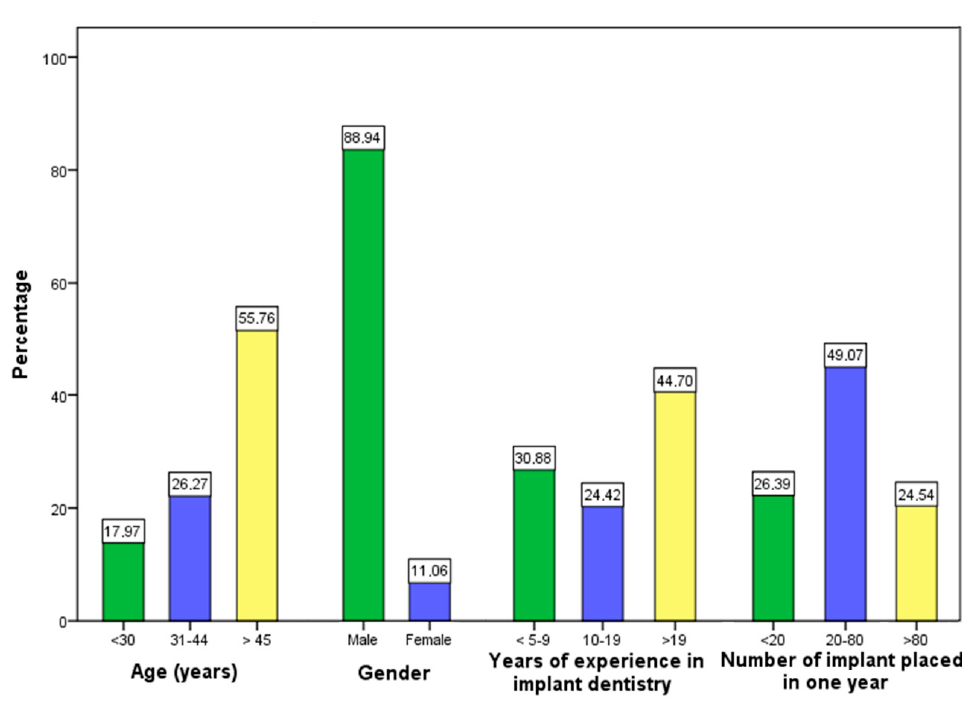
Figure 1. The distribution of the sample according to age, gender, years of experience in implant dentistry and number of implant placed in one year.